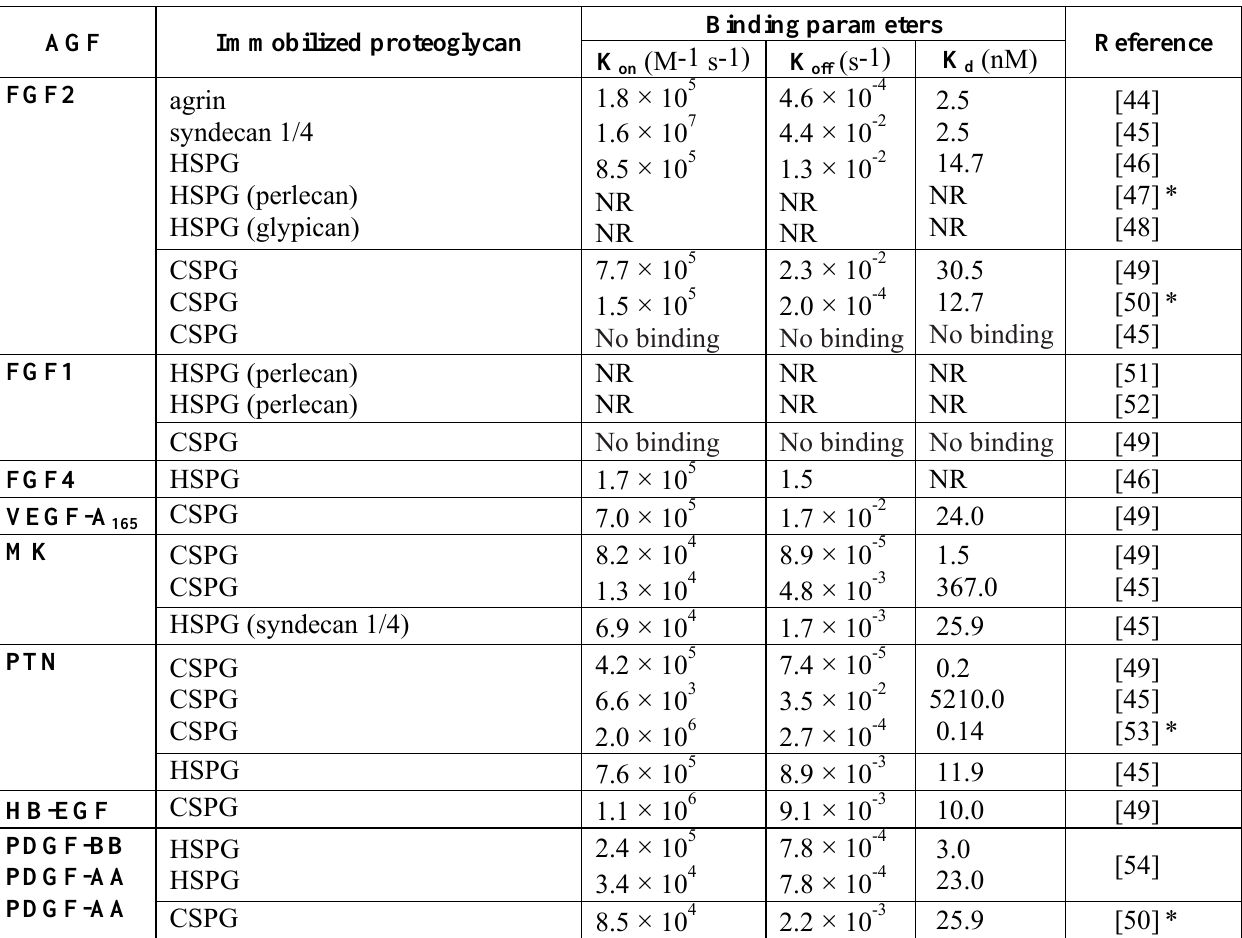
Table 2. SPR analysis of the interaction of AGFs with extracellular proteoglycans. Analyses were performed by using the free AGF as analyte and by immobilizing the indicated proteoglycan to the sensorchip. *studies performed by immobilizing the AGF to the sensorchip and using the proteoglycan as analyte. When not specified, the proteoglycan species was not identified. CSPG, chondroitin-sulfate proteoglycan; HSPG, heparan- sulfate proteoglycan; MK, midkine; PTN, pleiotrophin; HB-EGF, heparin-binding epithelial growth factor; NR data not